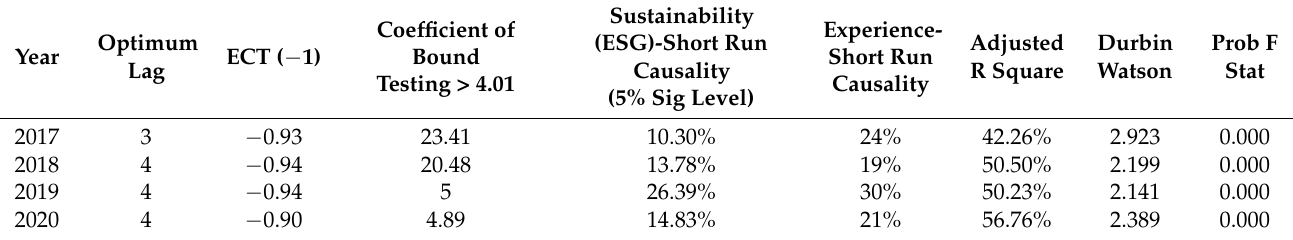
Table 9. Long run and short run, adjusted R square, and significance (2017 to